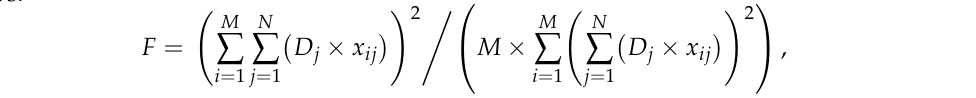
The RPSA Scheme The DOCR Scheme